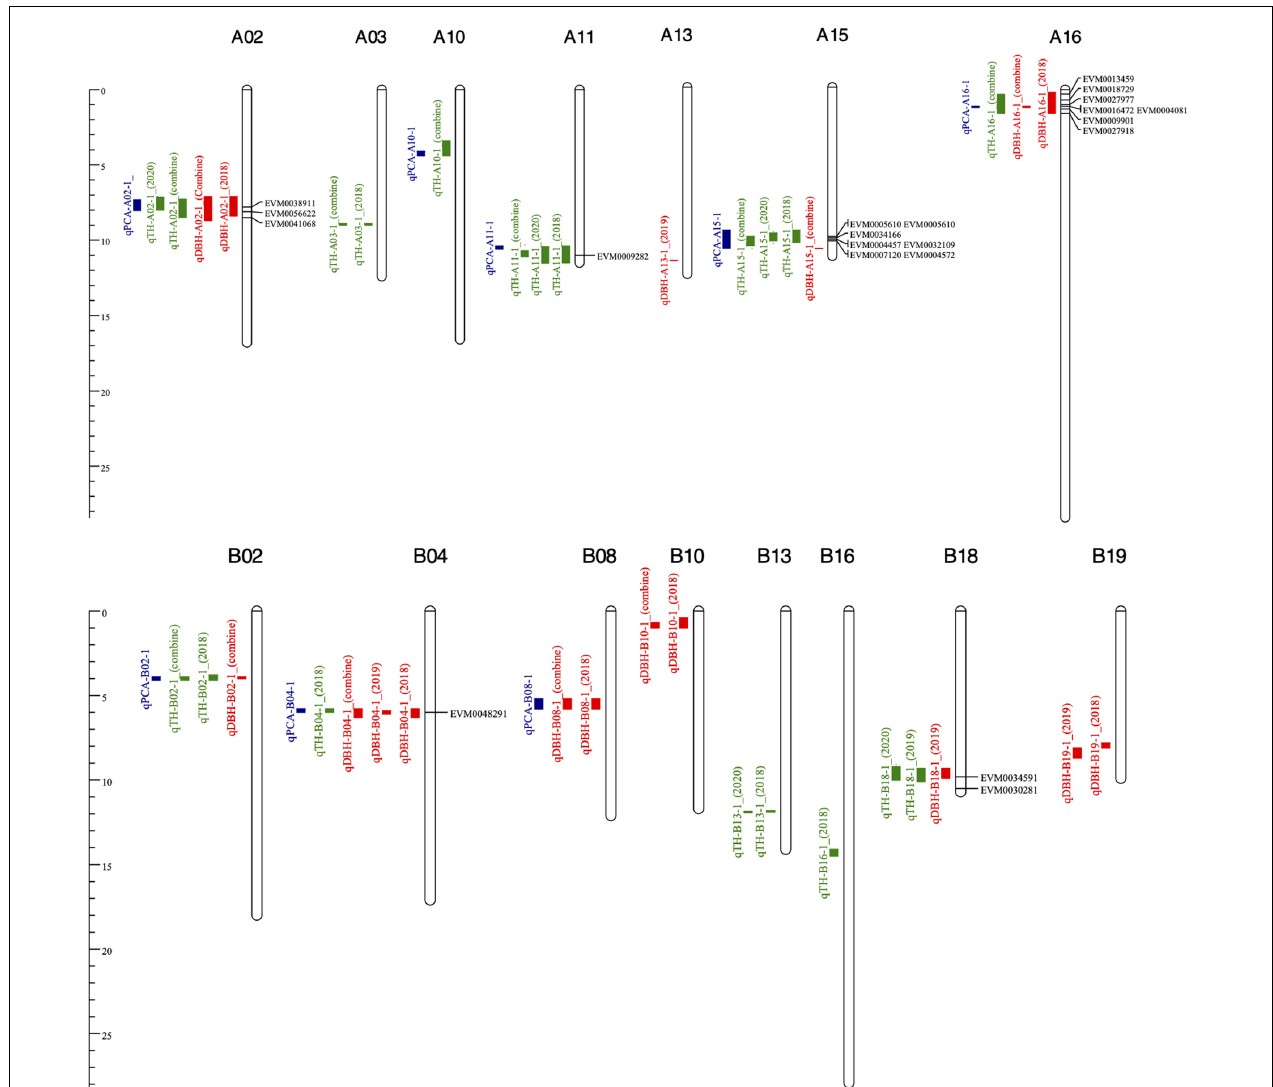
FIGURE 3 | QTL of TH, DBH, and PCA on the physical map. TH, DBH, and PCA QTL are marked in green, red and blue,